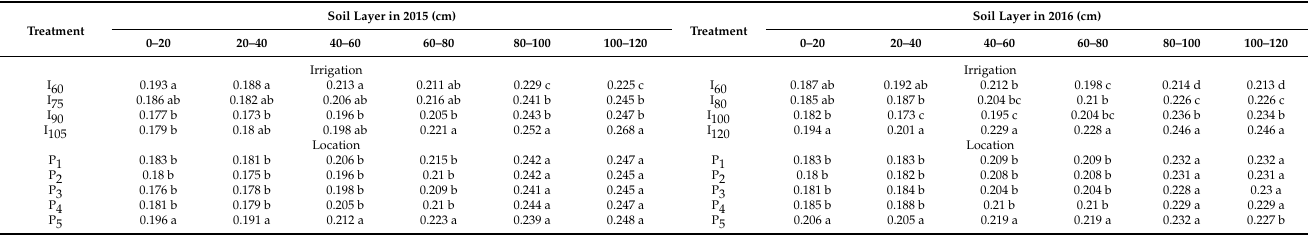
Table 1. Average SWC at different locations in different irrigation and fertigation